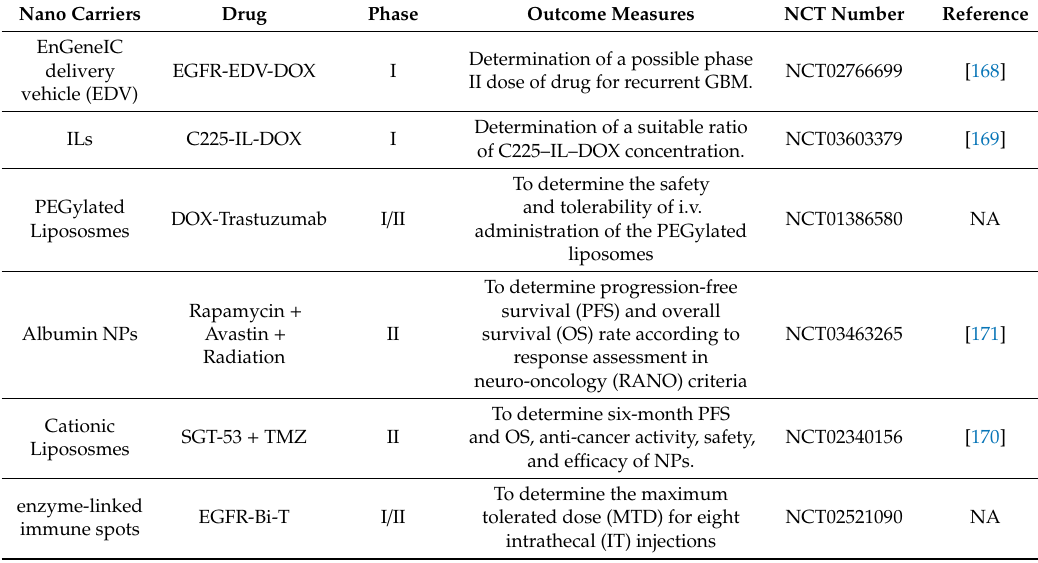
Table 3. List of Current Clinical Studies of